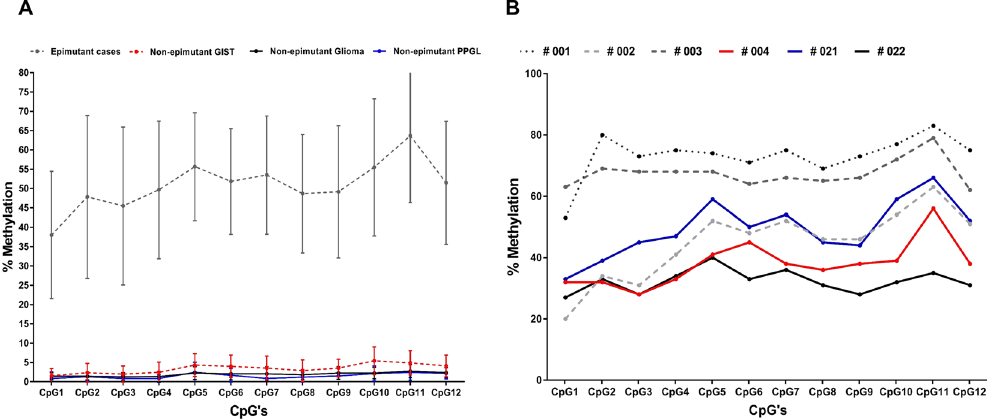
Figure 1. Figure ( A ) illustrates the distribution of methylation across the 12 individual CpG’s for the six cases demonstrated to have SDHC promoter methylation (epimutant cases), and the wt GIST, glioma and PPGL cases with no SDHC epimutation. Figure ( B ) demonstrates the methylation levels across the 12 individual CpG’s for the six epimutated cases (#001, #002, #003, #004, ##021,